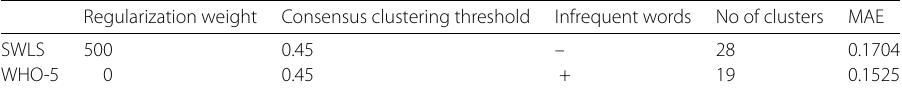
Table 5 Best word cluster